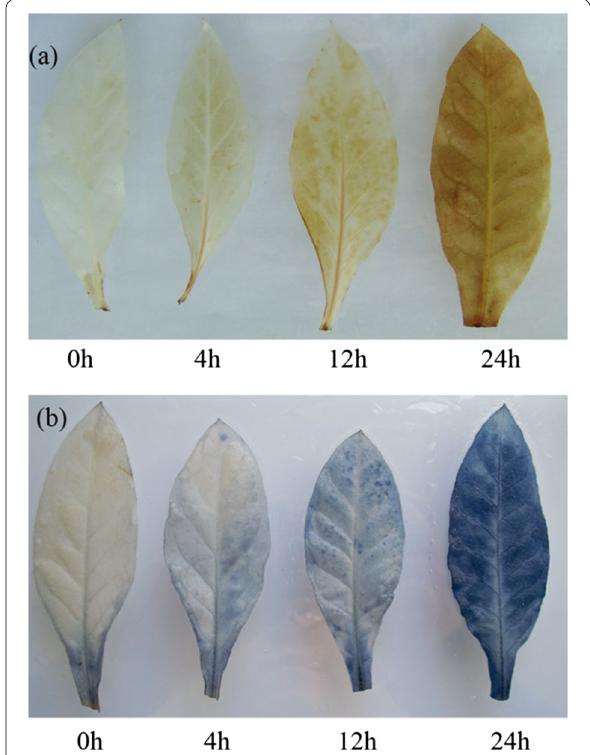
Fig. 5 Induction of ROS in tobacco leaves by AMEP412. a DAB showed the production of H 2 O 2 . The leaves were stained at different post treatment hours. H 2 O 2 accumulation appeared